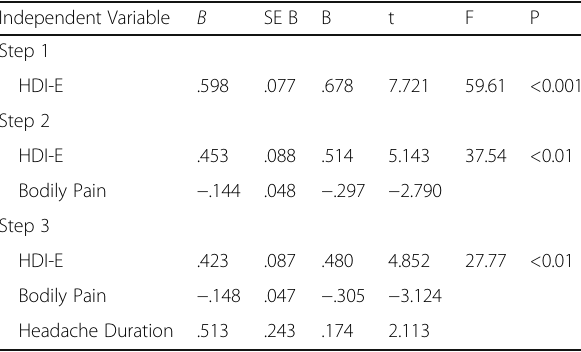
Table 3 Summary of Stepwise Regression Analyses to Determine Baseline Predictors of the Physical Burden of Headache at One Year (r 2 = 55.1%)